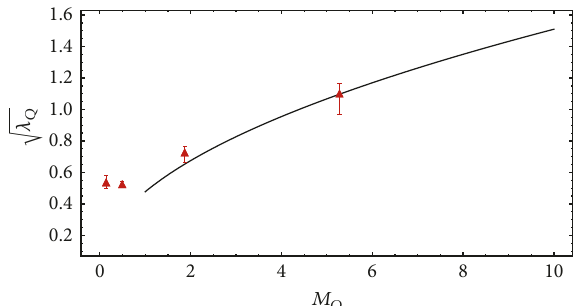
Figure4:Thescaleparameter √𝜆 fordifferentpseudoscalarmesons versus the meson mass. The solid line is the functional dependence √𝜆 ∼ √𝑀 푀 as predicted by